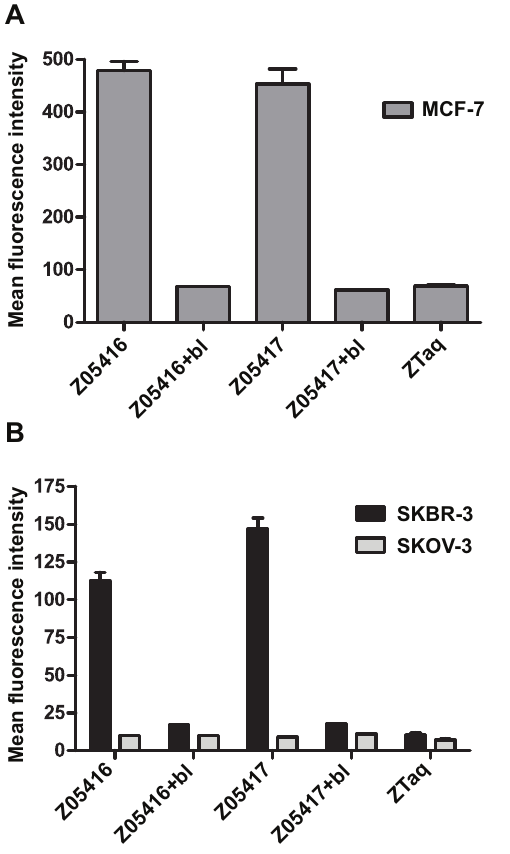
Figure 1. Cell binding of HER3-specific Affibody molecules analysed by flow cytometry. Binding of Alexa Fluor H 488-labelled Affibody molecules (150 nM) to: A. MCF-7, B. SKBR-3 and the HER3- negative cell line SKOV-3. ‘‘Bl’’ = blocking with 15 m M of the corresponding, non-labelled Affibody. MCF-7 cells were stained in a separate experiment, whereas SKBR-3 and SKOV-3 were stained simultaneously.